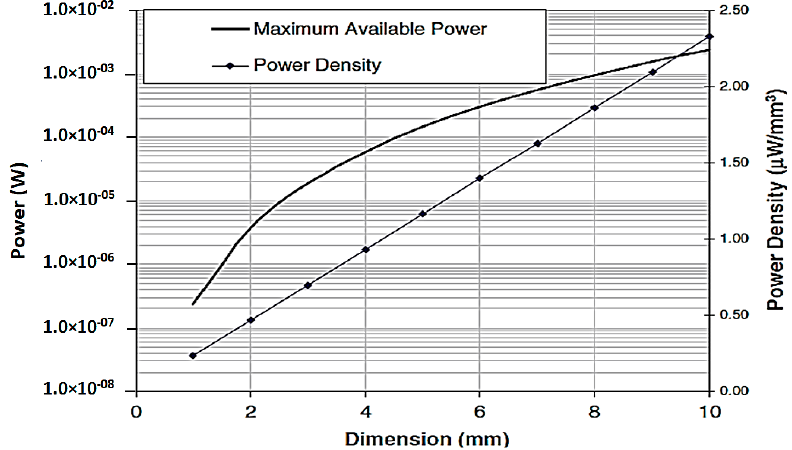
Figure 5. Power density with maximum available power dimension for the electromagnetic vibration generator structure [42].